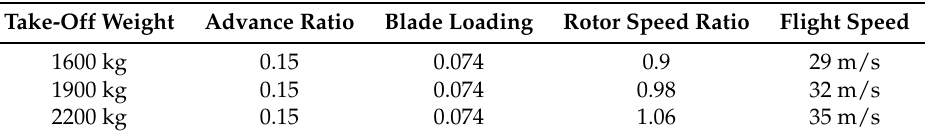
Table 2. Variable-speed rotor low flight speed cases.